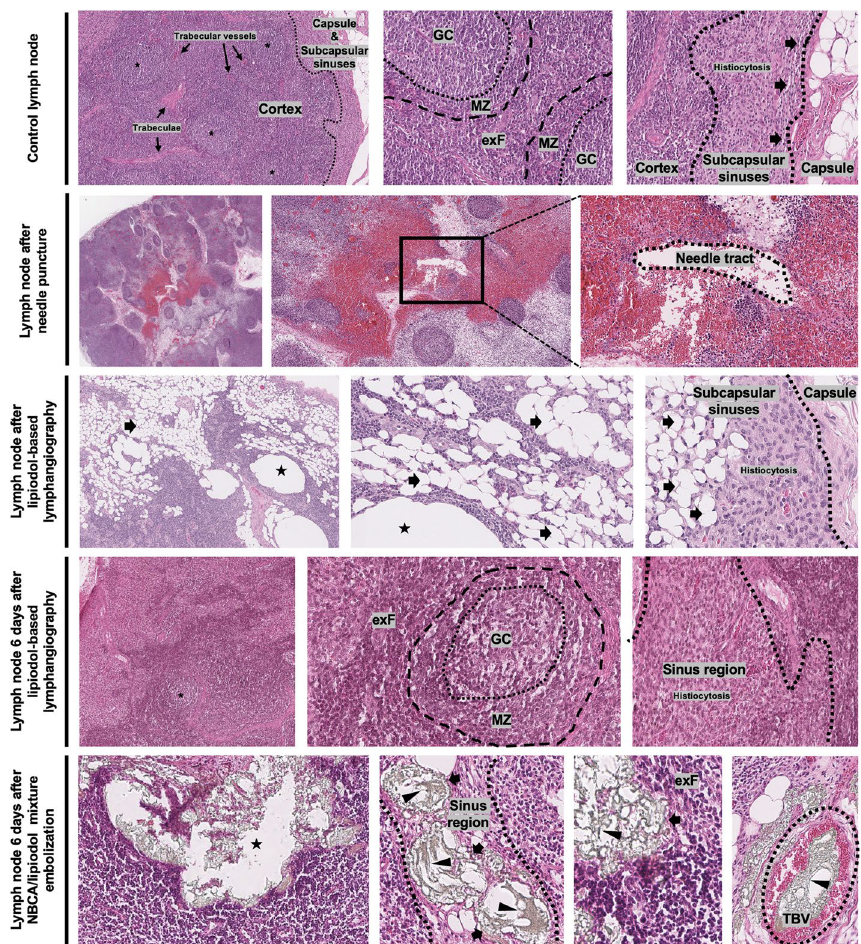
Fig. 13 Histopathological demonstrations before and after lipiodol-based INL and INE. The upper row shows an unaffected lymph node structure with outer capsule and subcapsular sinuses, lymphoid follicles (*), and uniform extrafollicular regions (exFs) in the cortex with extended trabeculae and trabecular blood vessels; in each follicle, germinal center (GC) and mantle zone (MZ) are sharply demarcated; besides, there are contact sinuses and moderate histiocytosis beneath the capsule. The second row shows a parenchymal defect of the needle tract with surrounding hemorrhage and focal necrosis. The third row shows extensive empty spaces within the dilated sponge-like sinuses (black arrows) and dilated blood vessels (asterisks) after lipiodol-based INL due to the histological preprocessing. The fourth row shows the restoration of extensive empty spaces without any persistent parenchymal injury 6 days after lipiodol-based INL. The lowest row shows the glue (black arrowhead) injected in INE was seen both within the sinuses (black arrows) and trabecular blood vessels (TBVs), with mildly focal nuclear pyknosis and partial loss of intercellular borders after 6 days. All images were from Pig No. 7&8 under standard HE stains. Notes: *, lymphoid follicle; asterisk, blood vessel; black arrow, lymphatic sinus; black arrowhead, consolidated glue framework. Abbreviations: GC, germinal center; MZ, mantle zone; exF, extrafollicular zone; TBV: trabecular blood vessels; INL, intranodal lymphangiography; INE, intranodal